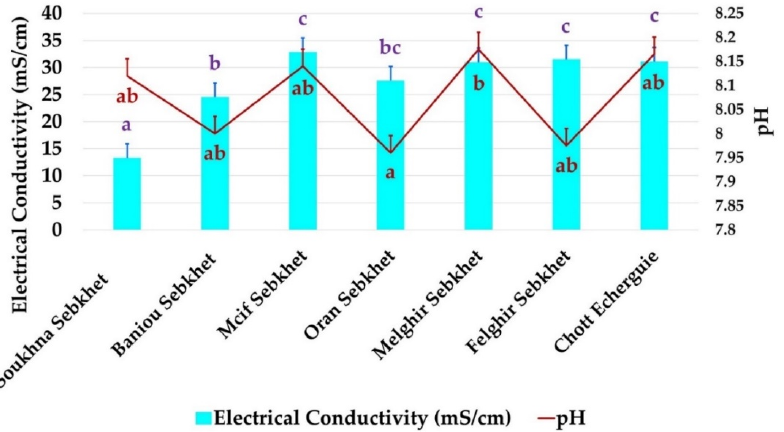
Figure 2. Soil chemical and physical properties of the seven Sebkhet and Chott sampled. Data present mean ± standard error. Bars labelled with different letters are significantly different among the treatments at p < 0.05 using Tukey’s honest significant difference (HSD) test. In each bar groups, bars labelled with the same letter are not significantly different from each other according to Tukey’s HSD at p < 0.05. (Letters with Blue and red colors belong to EC and pH,